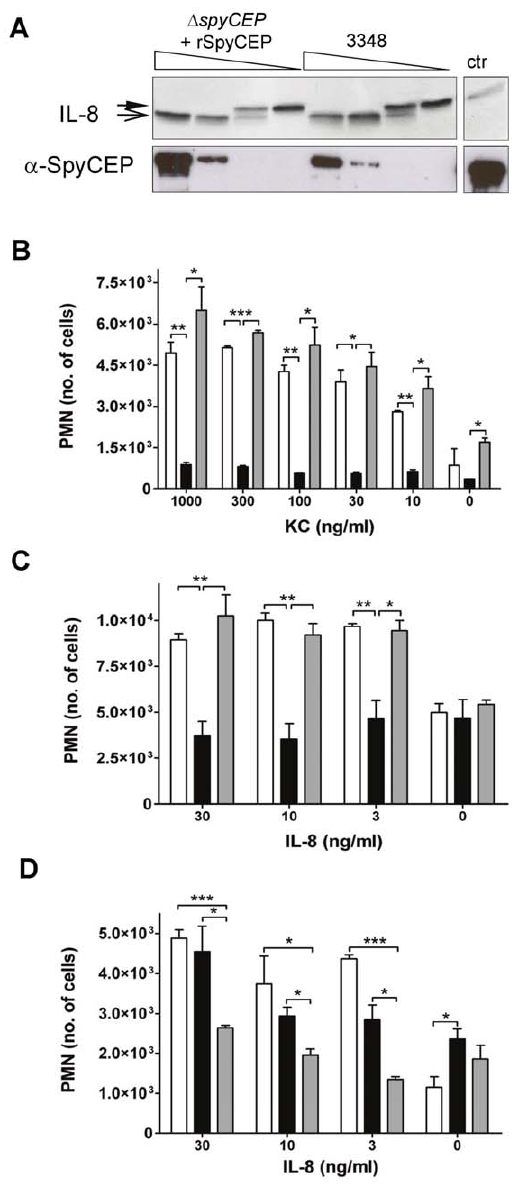
Figure 5. Activity of rSpyCEP and PMN transmigration. ( A ) Comparison of rSpyCEP and native SpyCEP activity on IL-8. SDS-PAGE (18% Tris-Glycine) and silver staining after 2 h of digestion with 5 ng, 1 ng, 0.2 ng, 0.04 ng or 0 ng (ctr lane) of rSpyCEP + 3348 D spyCEP extracts (left). Cell wall extracts containing comparable amounts of native SpyCEP from 3348 extracts (right). Full and trace arrowheads